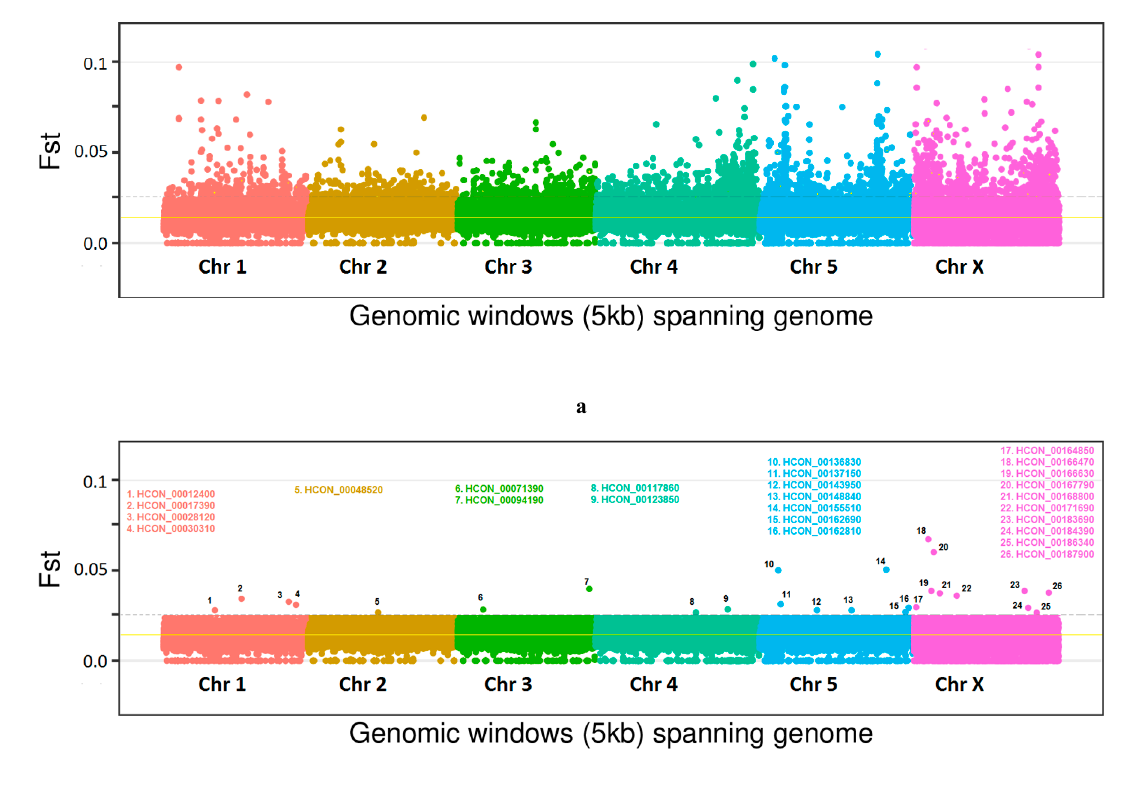
Figure 4. Genome-wide pairwise Fst analysis between the IVM-sensitive (SXS) and IVM-resistant (SXR) strains. Both of these strains had a very close geographic background. Elevated points are the significantly differentiated genomic windows across the genome. Yellow line shows the genome-wide average Fst cut-off. Dotted line shows the top 5% cut-off value. ( a ) All the 5 kb windows spanning the genome. ( b ) Windows containing the 26 candidate genes of IVM resistance which were selected in the present study on the basis of their functional annotations in relation to IVM resistance.